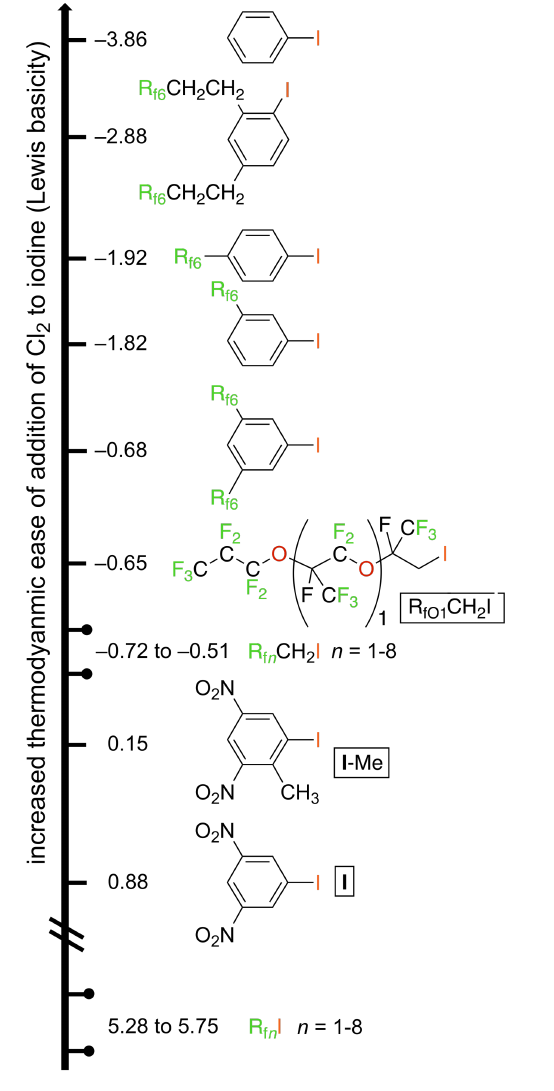
Figure 4: Free energies of chlorination of relevant aryl and alkyl iodides to the corresponding iodine(III) dichlorides in the gas phase (kcal/mol), presented in a ladder format (each iodide is more Lewis basic than that shown below it).